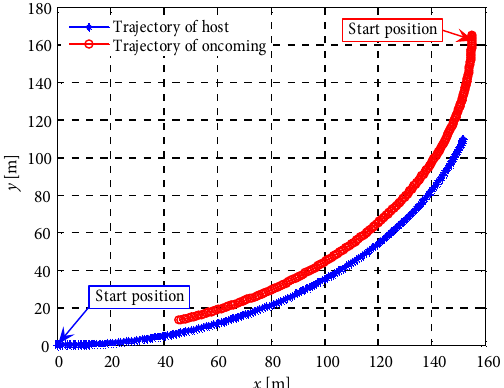
Fig. 2. Ideal trajectories of both vehicles